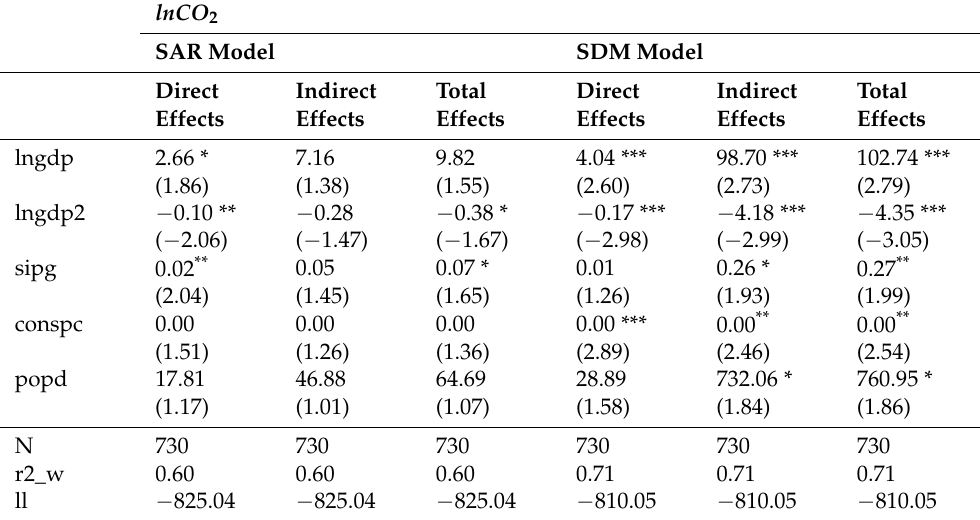
Table 4. (Direct/Indirect) Effects of spatial